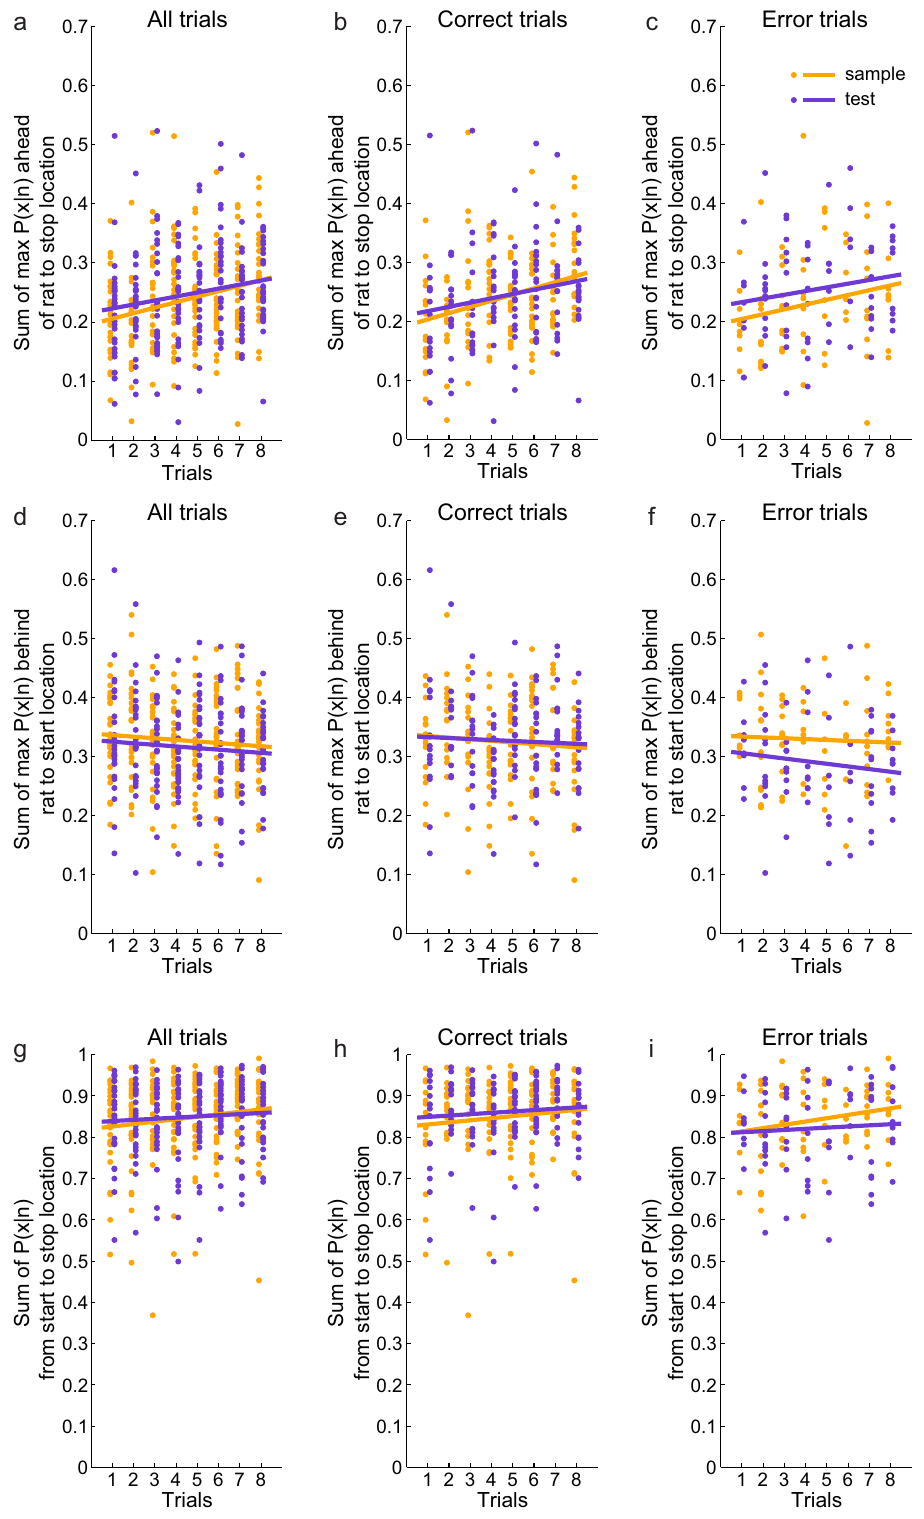
incorrect stop locations during the test phase of error trials. We represented during correct and error trials, we decoded place cell detected epochs that showed signi fi cant sequential structure and ensemble activity as rats ran toward their eventual stop locations. measured these sequences ’ slopes as an estimate of sequence The stop location was the same as the correct reward location on compression and direction of decoded paths (see Methods). We correct and error trials during the sample phase of the task. The hypothesized that place cell sequences representing paths toward stop location was the same as the correct reward location during the upcoming stop location would be more prominent during the the test phase of correct trials but corresponded to animals ’ NATURE COMMUNICATIONS| (2021) 12:3373